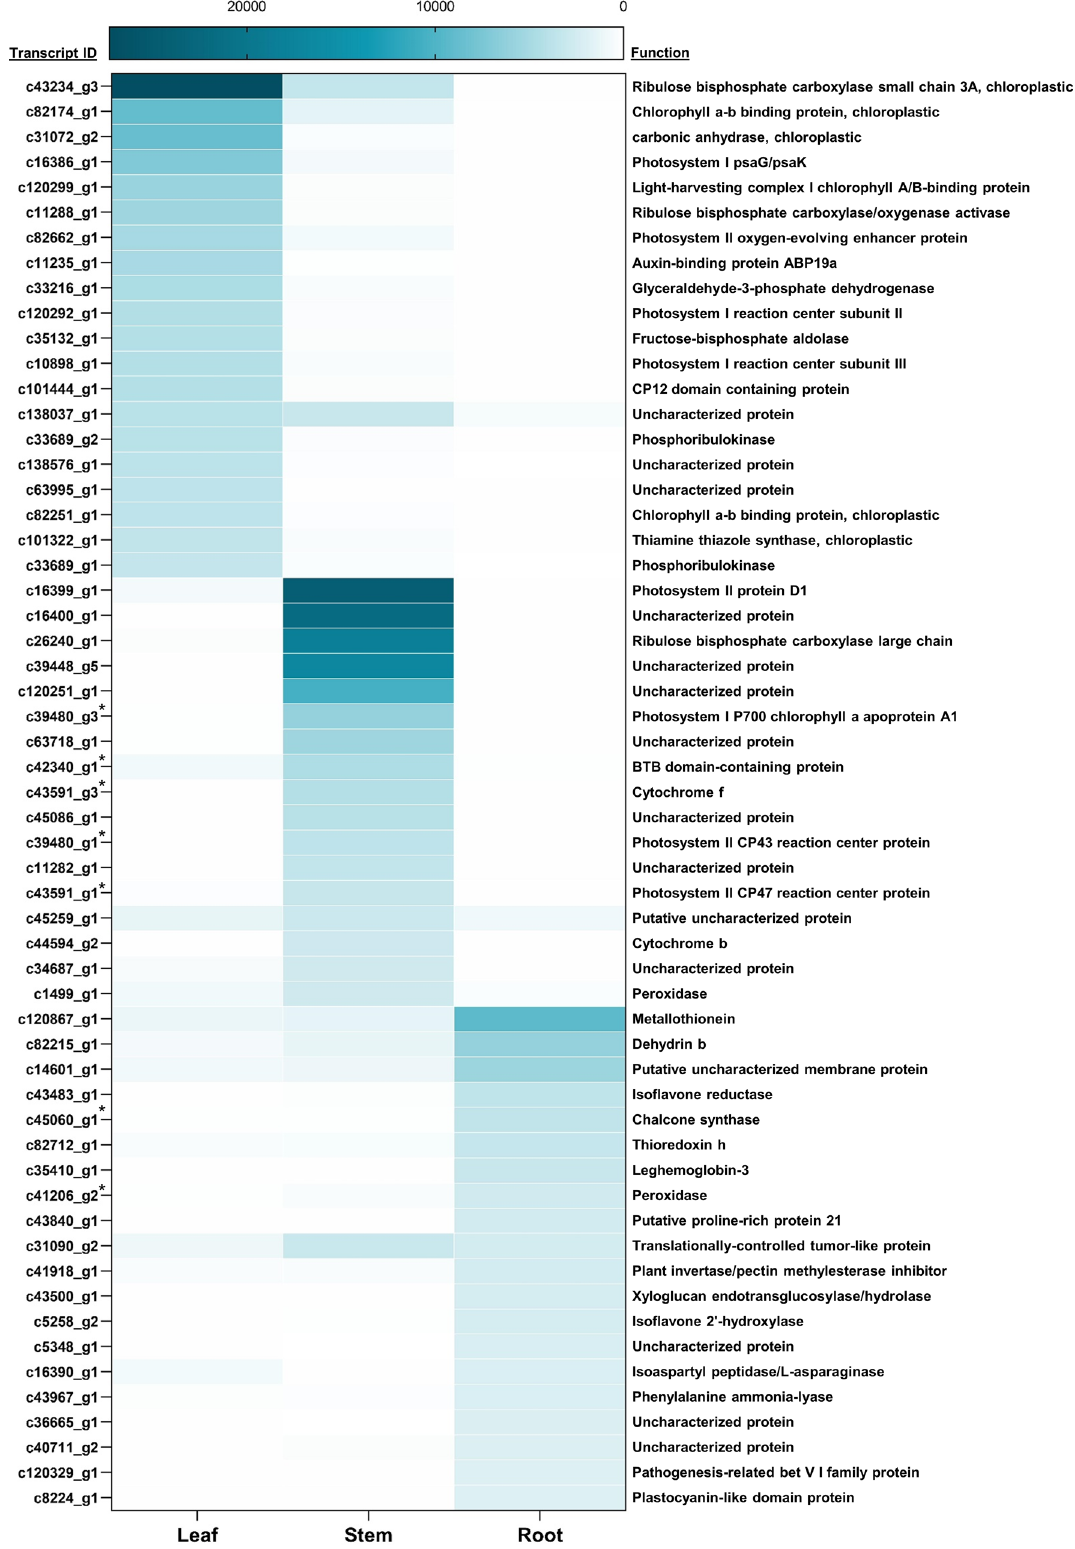
Figure 3. Heatmap for top 20 most abundant transcripts (based on average TPM values) from leaf, stem and root tissues. The * sign indicates transcripts with multiple annotations. The annotation derived from the best hit have been ascribed for such